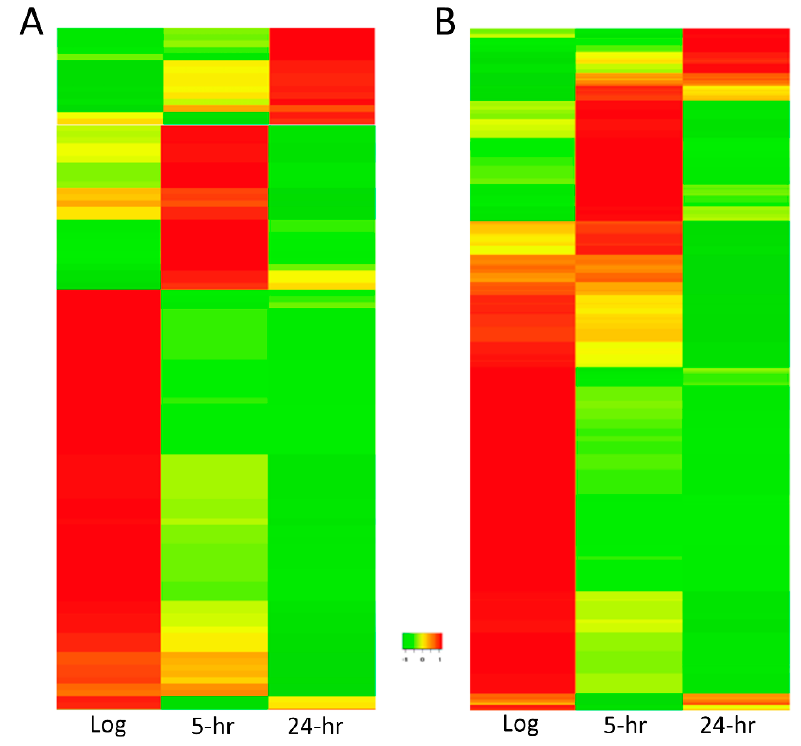
Figure 6. Heat maps depicting gene expressions of novel sRNAs. ( A ) Heatmap [22] of intragenic sRNAs. ( B ) Heatmap of intergenic sRNAs. Log, log phase; 5-h, 5 h C-starved; 24-h, 24 h C-starved.